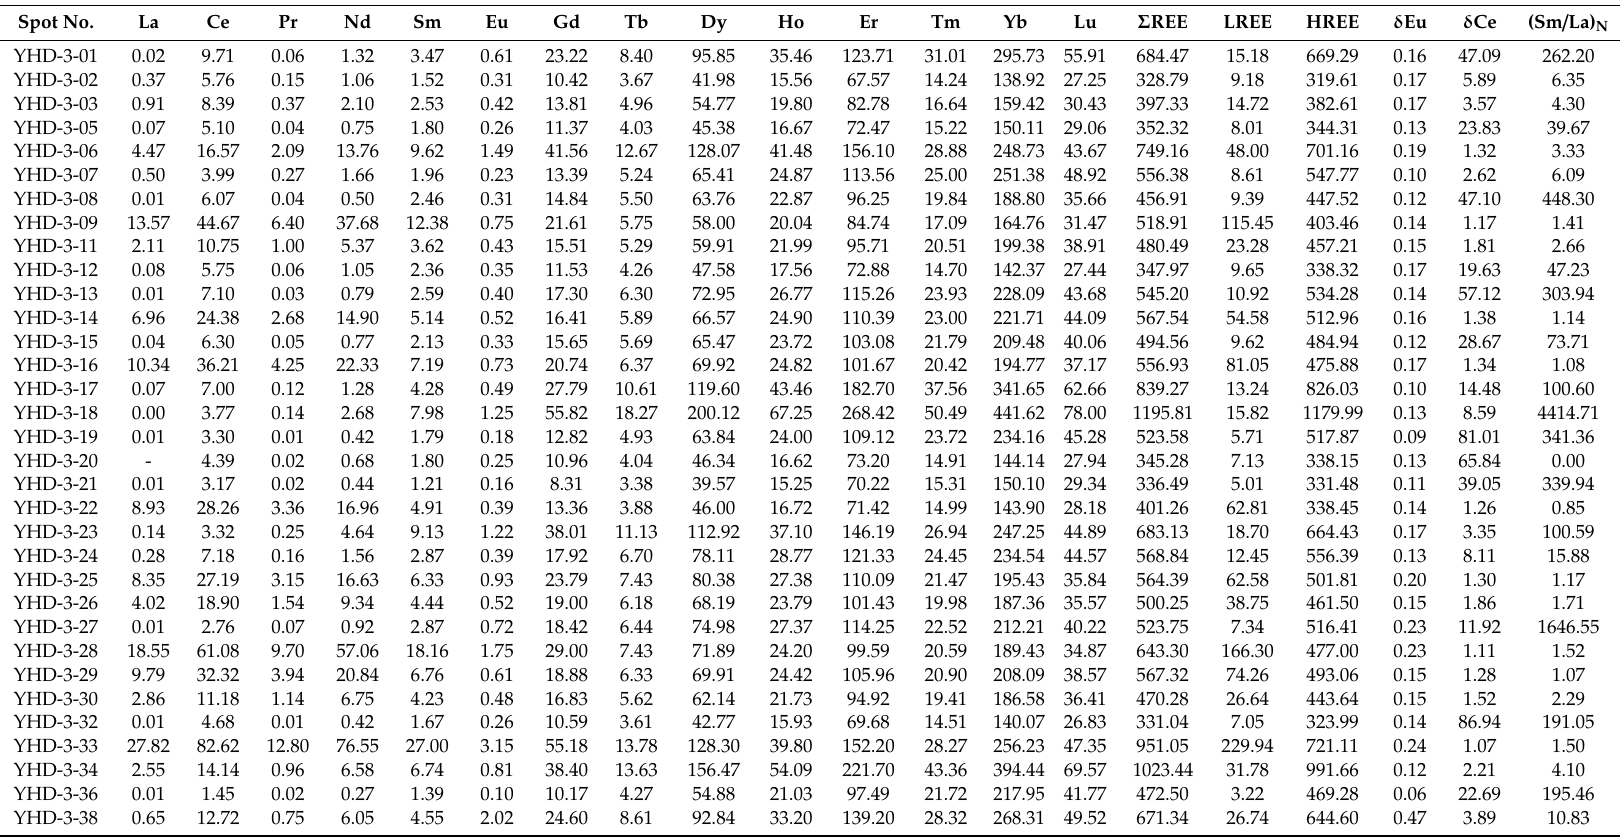
Table 2. Analysis of rare earth elements in zircons